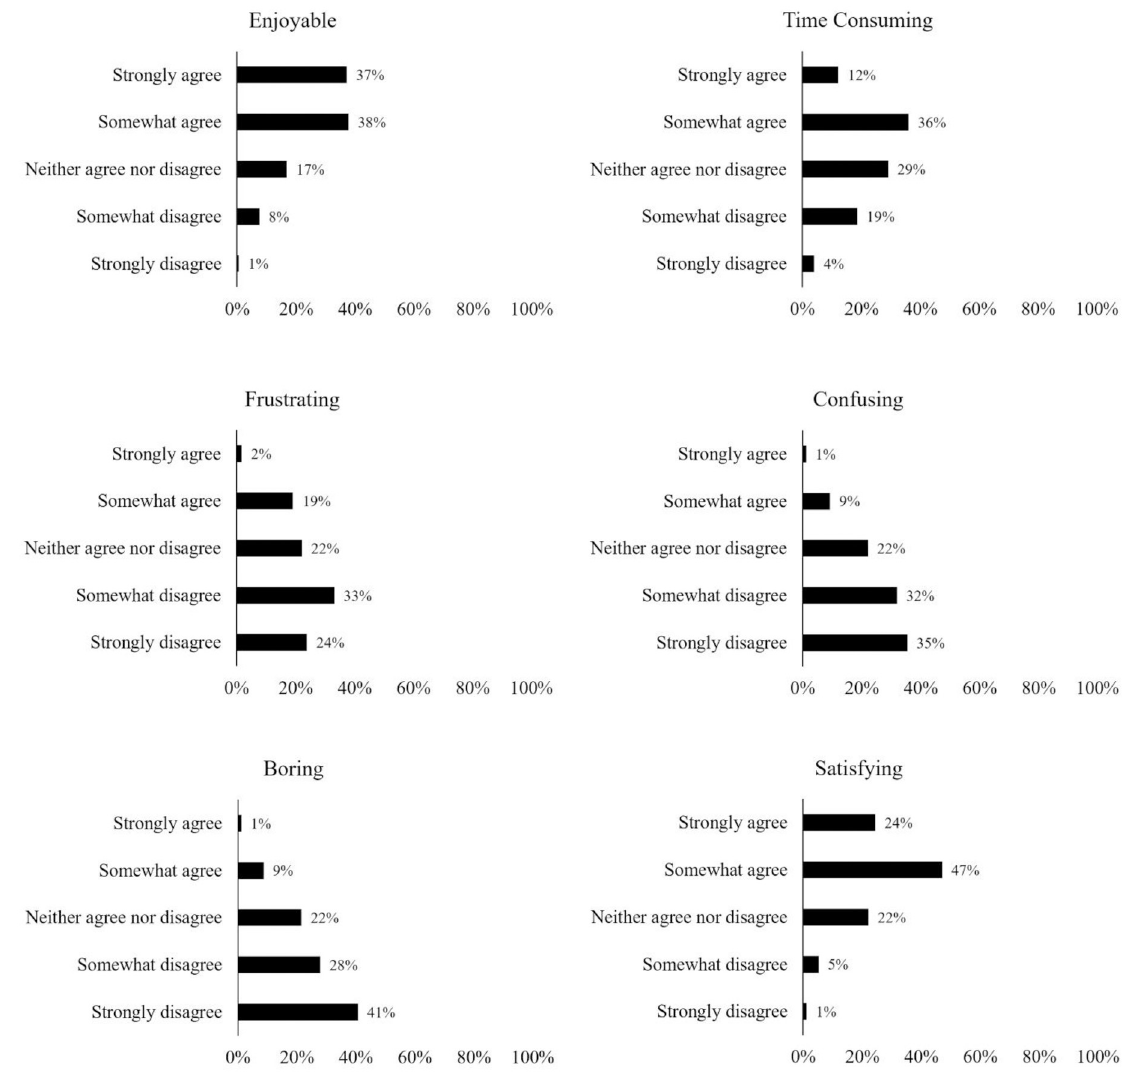
Fig 3. Response distributions for the game decision